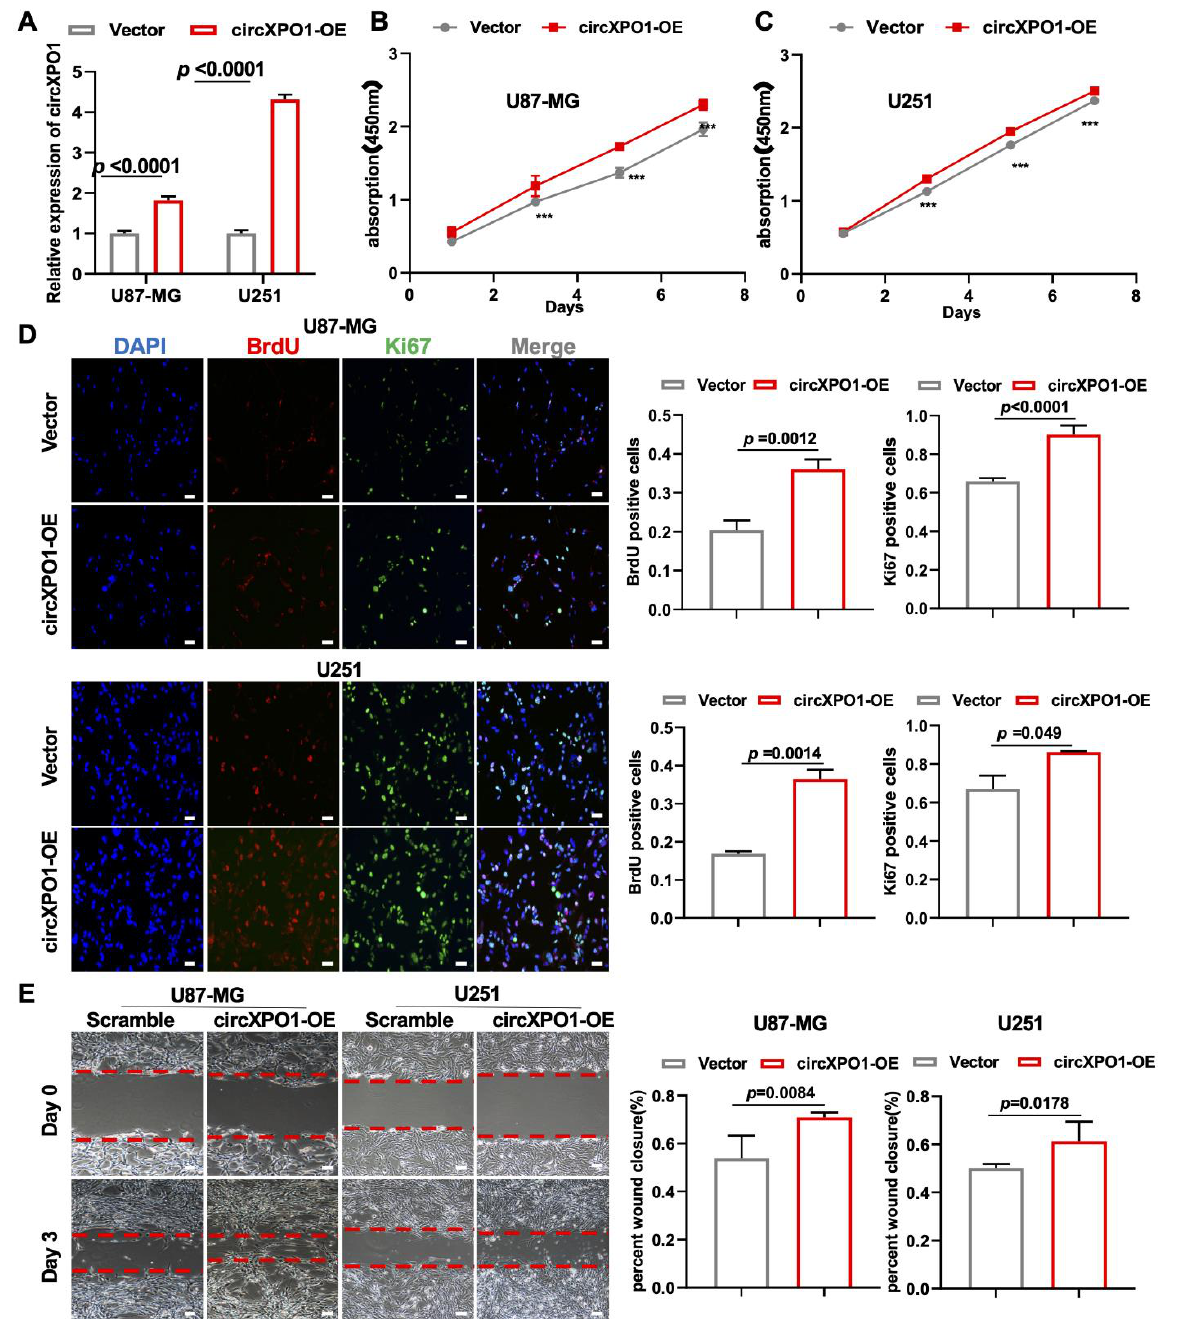
Figure 3. circXPO1 gain-of-function enhances GBM cell proliferation and migration. ( A ) The overexpression of circXPO1 in GBM cells was validated by qPCR after 72 h transfection. ( B , C ) Growth curves of GBM cells with or without circXPO1 overexpression were plotted by CCK-8 assays. “***” indicates p < 0.001. ( D ) Immunofluorescent staining showed the Ki67- and BrdU-positive cells in circXPO1-overexpressed U87-MG and U251 cells. The rates of BrdU- and Ki67-positive cells were calculated with Image J on the right side, scale bar = 100 µ m. ( E ) Effects of circXPO1 overexpression on U87-MG and U251 cell migration, scale bar = 100 µ m. The wound closure was quantified by the Image J wound healing tool on the